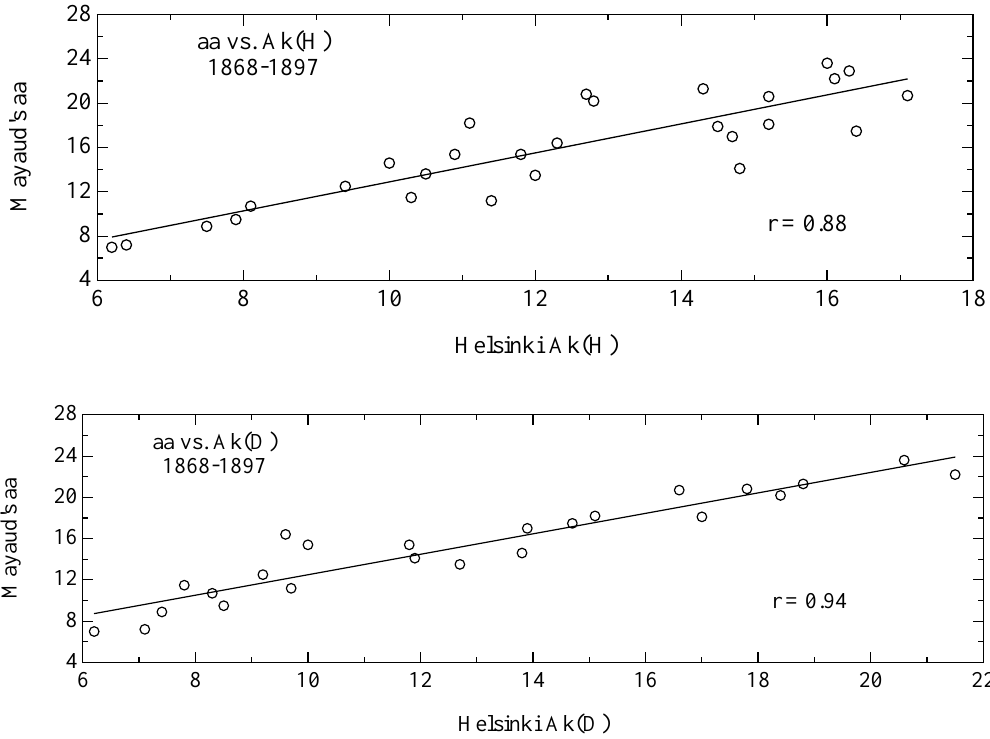
Fig. 9. Comparison between annual means of Mayaud’s aa and Helsinki activity indices Ak(H) (top) and Ak(D) (below). The Helsinki- indices overlap aa -index by 30 years from 1868 to 1897. There are linear relationships between the indices: aa = − 0.2 + 1.31 Ak(H) and aa =2.5 + 0.99 Ak(D) with correlation coefficients of 0.88 and 0.94,